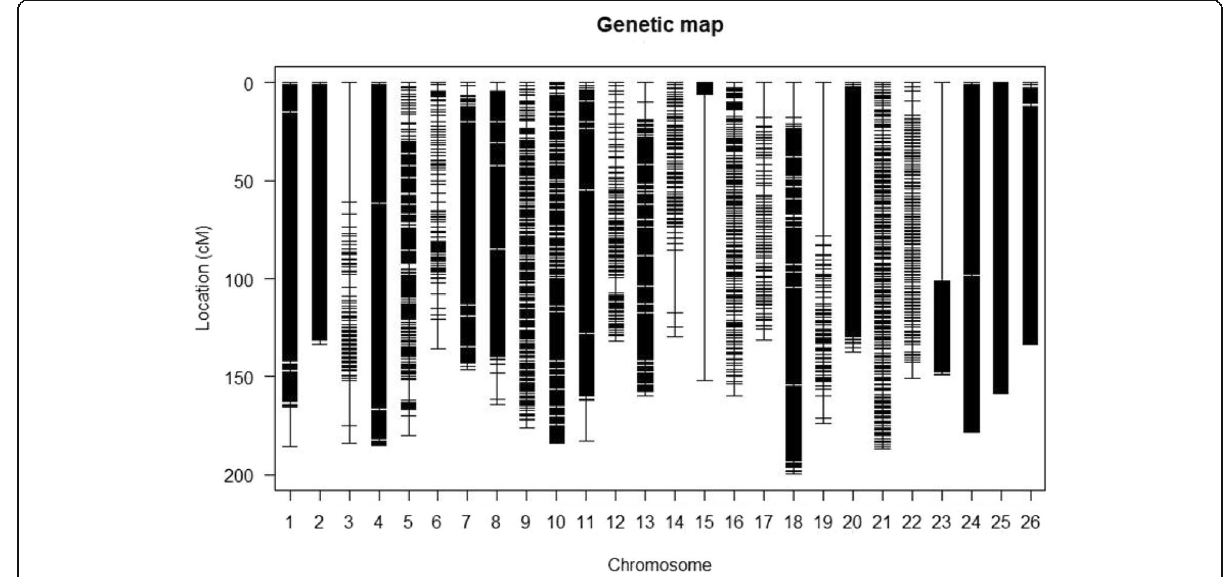
Fig. 2 Dense genetic linkage map constructed by the use of GBS sequence